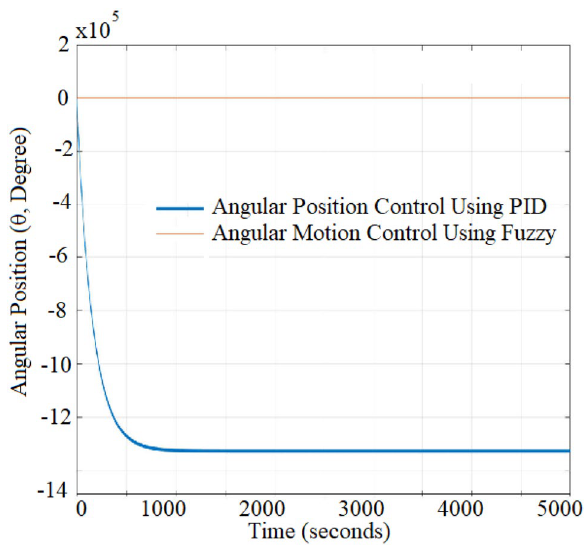
Fig. 16 Graph of both conventional PID and FLC results for com- parisons